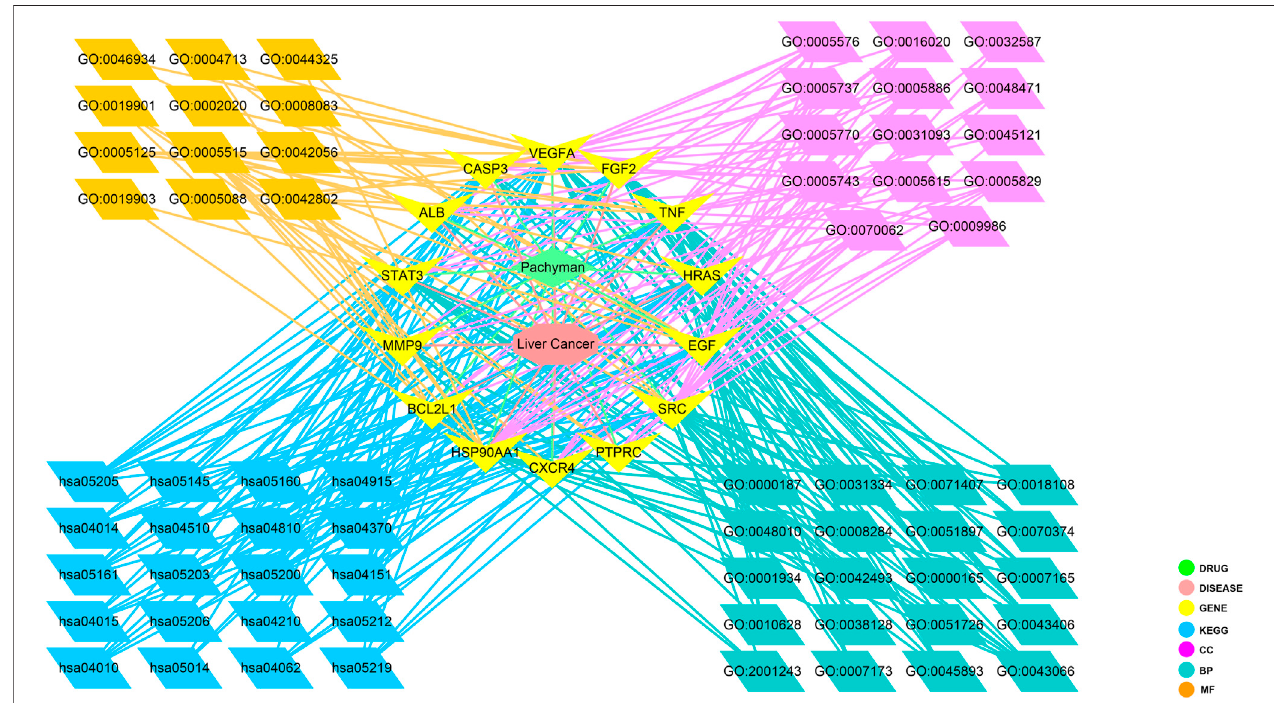
FIGURE 5 | An integrative map of disease and ingredient-target-signaling pathway network of Pachyman in treating HCC.